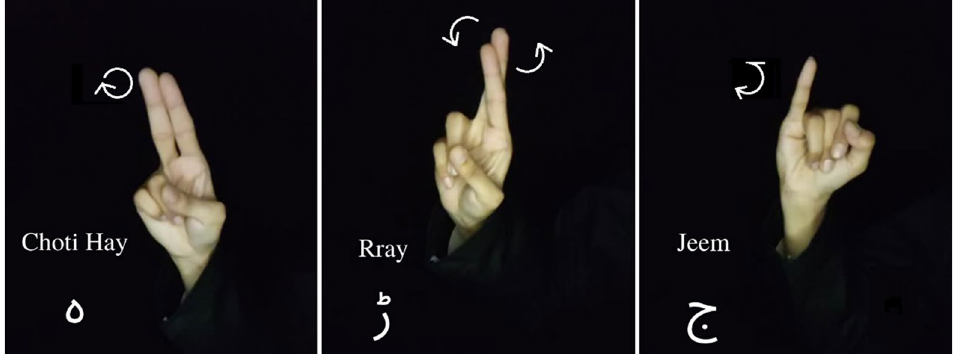
Figure 2. PSL dynamic